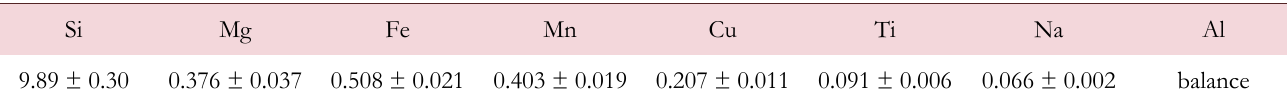
Table 1: Chemical composition (wt. %) of the gravity cast AlSi10Mg